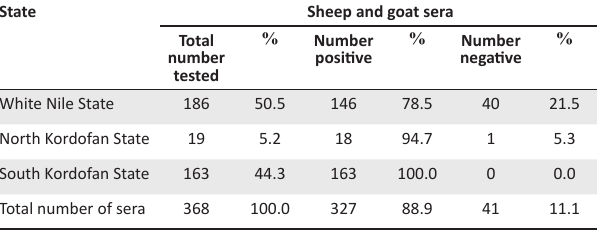
TABLE 3: The overall seroprevalence of peste des petits ruminants virus antibodies in both sheep and goat sera in surveyed States of Sudan. State